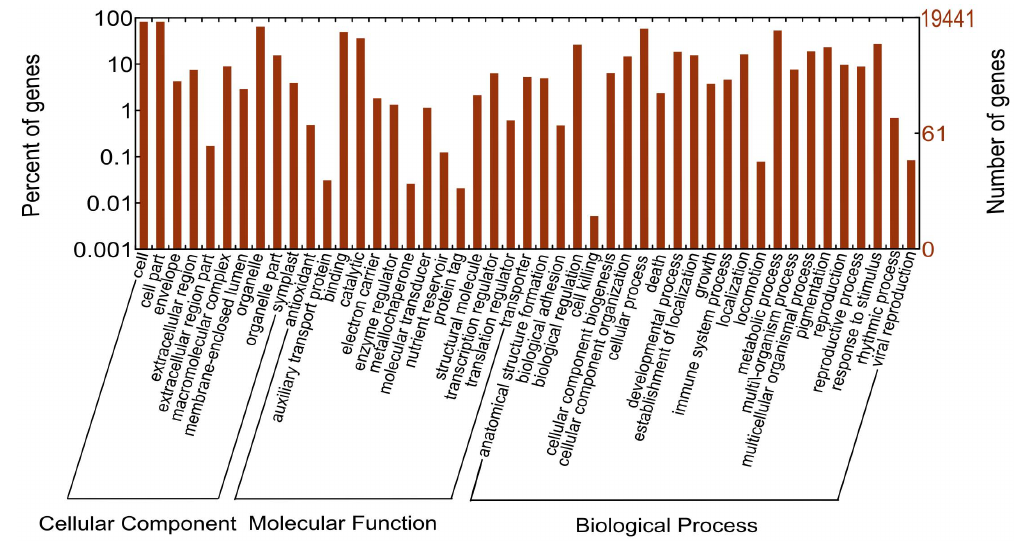
Figure 2. Histogram presentation of Gene Ontology classification of the assembled unigenes.